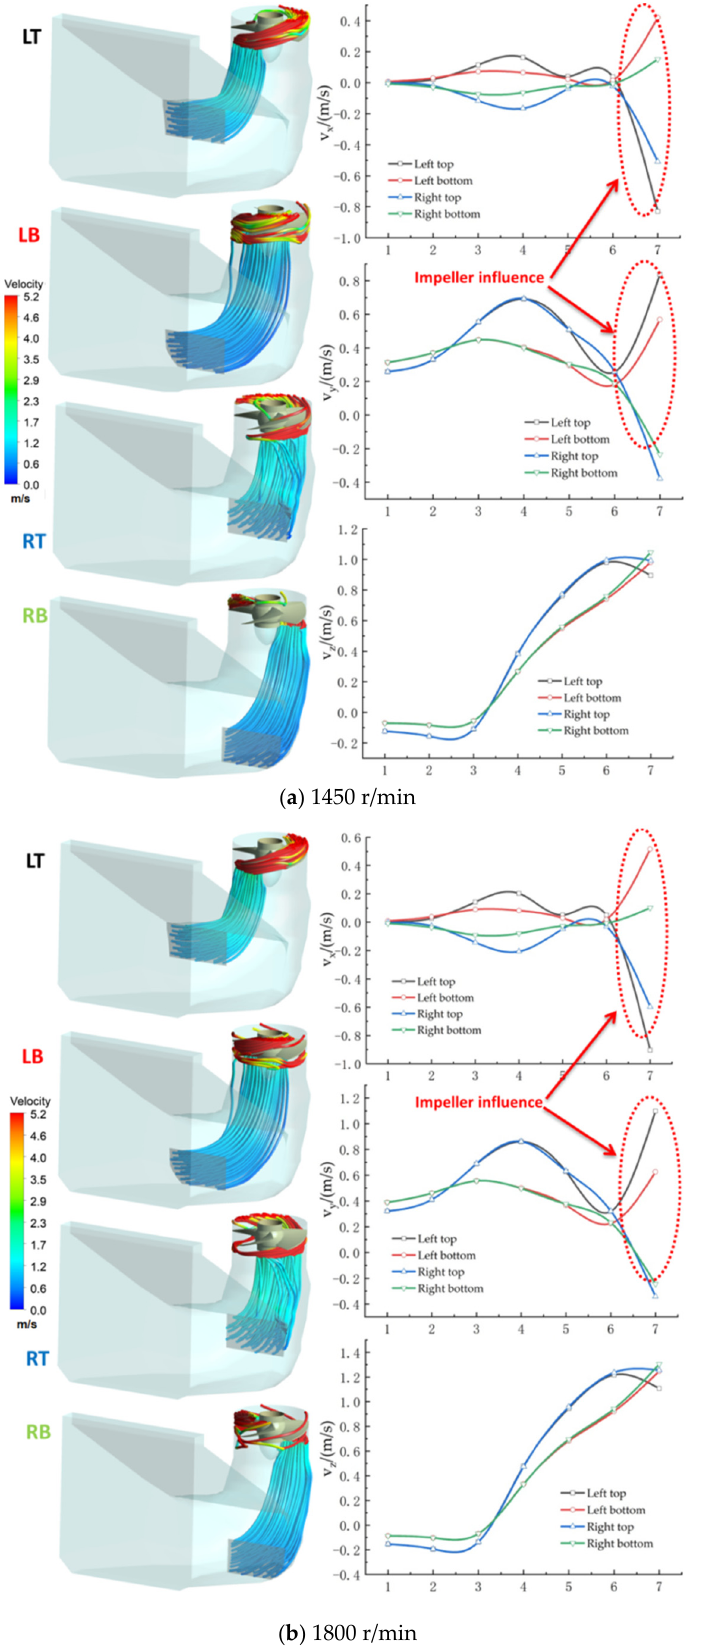
Figure 12. Fluctuation of velocity component distribution along the elbow inlet conduit.